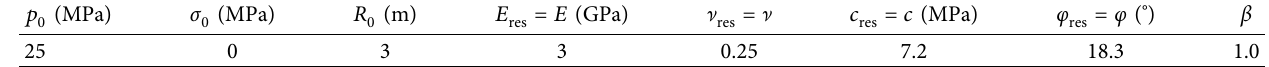
Table 3: The mechanical and geometrical parameters of circular opening.